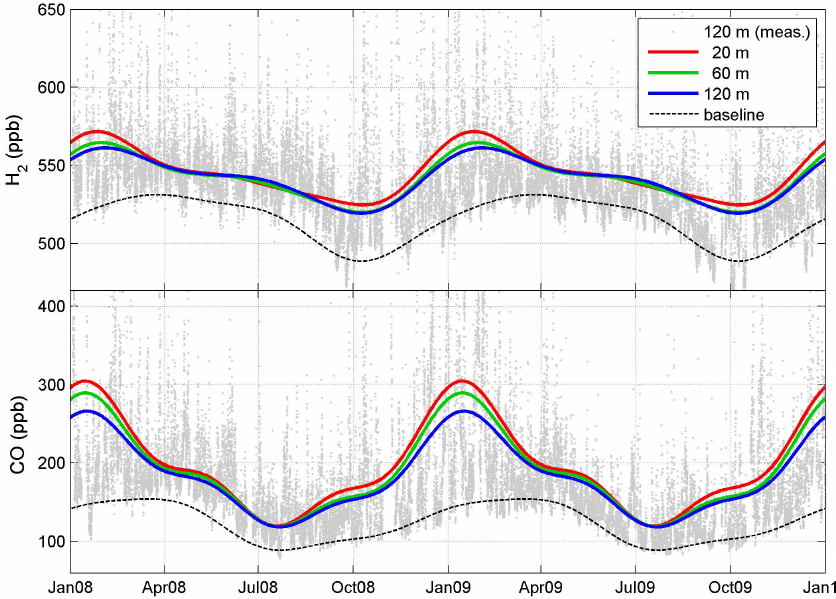
Fig. 4. Seasonal cycles of H 2 and CO at three sampling heights (colour lines) and the baseline at 120m (black dashed line). Grey dots are the measurement series from 120m sampling